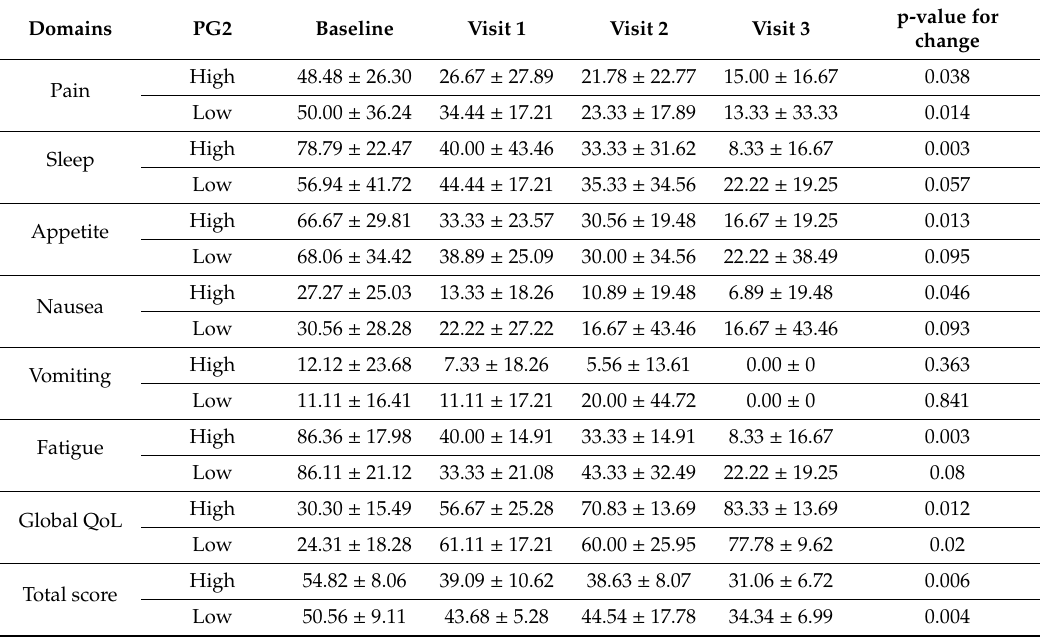
Table 2. European Organization for the Research and Treatment of Cancer (EORTC) quality of life questionnaire